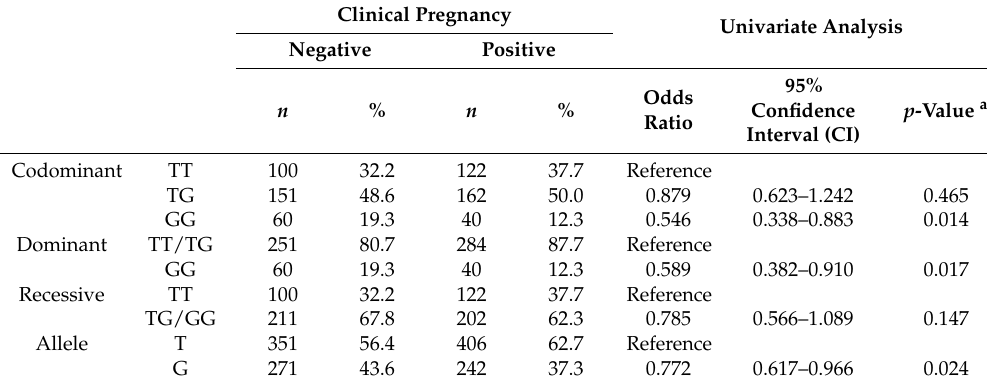
Table 4. Frequencies of AMH 146T > G (rs10407022) polymorphism among women with different IVF